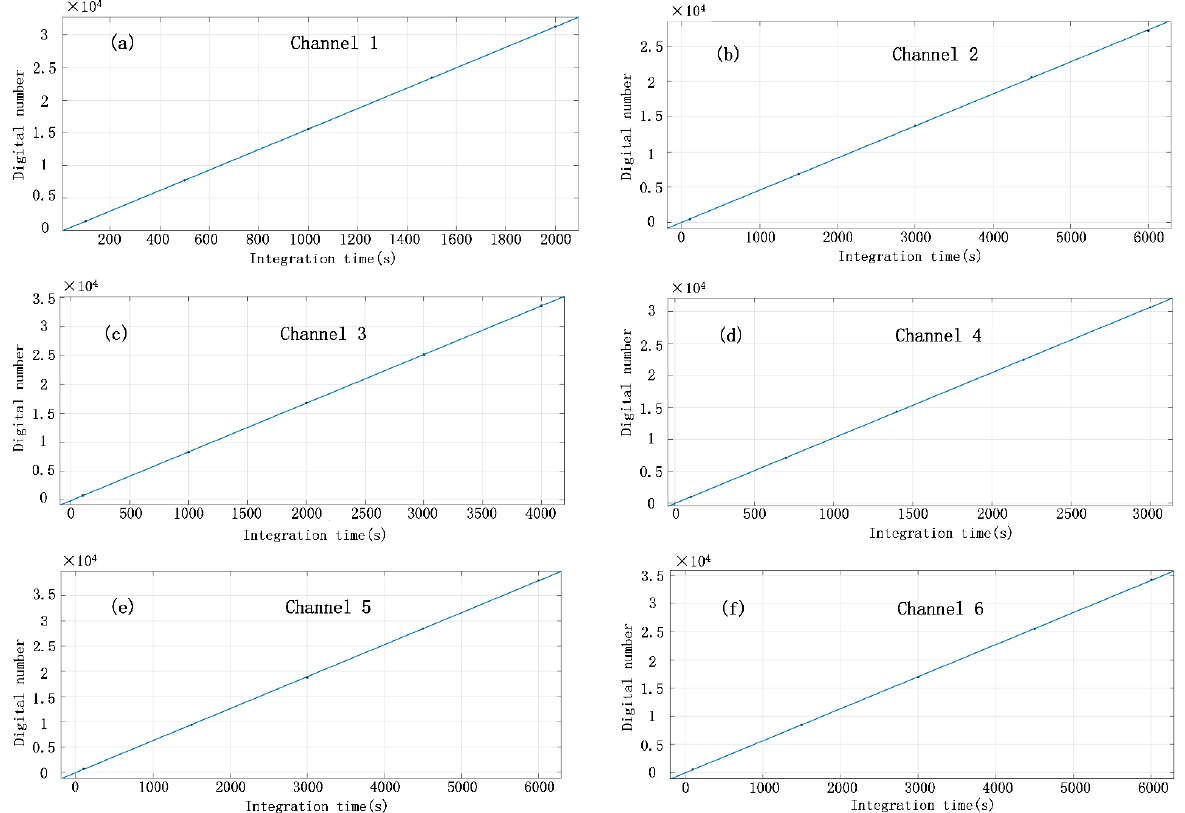
Figure 20. Fitting results of the linear integrated time response of the 1024 PBSC for the six chan ‐ nels: ( a ) Channel 1; ( b ) Channel 2; ( c ) Channel 3; ( d ) Channel 4; ( e ) Channel 5; ( f ) Channel 6.